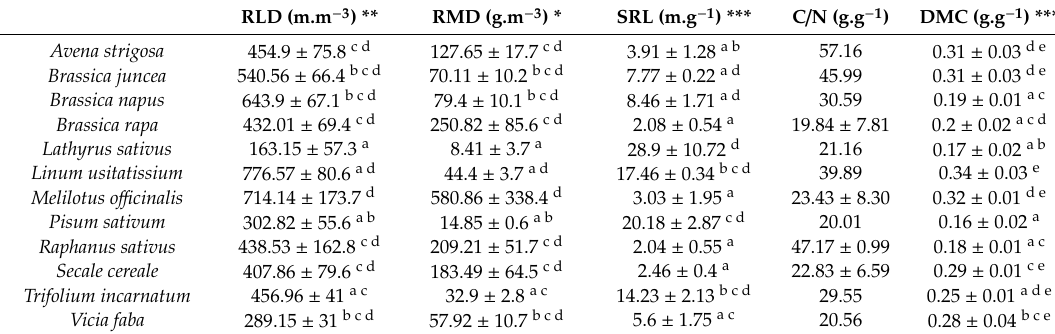
Table 3. Root traits–values per